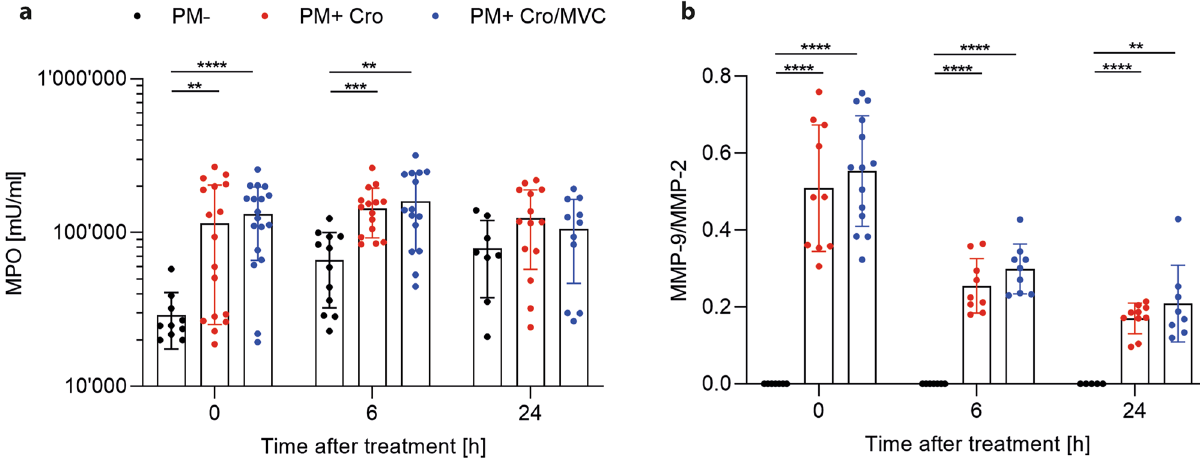
Figure 7. Neutrophil-associated inflammatory parameters. Myeloperoxidase (MPO) (PM- n = 8–12; PM + Cro n = 14–17; PM + Cro/MVC n = 11–18, depending on timepoints) ( a ) and matrix metalloproteinase 9 (MMP-9) (PM- n = 5–7; PM + Cro n = 9–10; PM + Cro/MVC n = 8–14, depending on timepoints) ( b ) were not affected by MVC treatment at any given timepoint. Data are presented as mean ± SD. * p < 0.05, ** p < 0.01, *** p < 0.001, and **** p < 0.0001 (Two-way ANOVA).